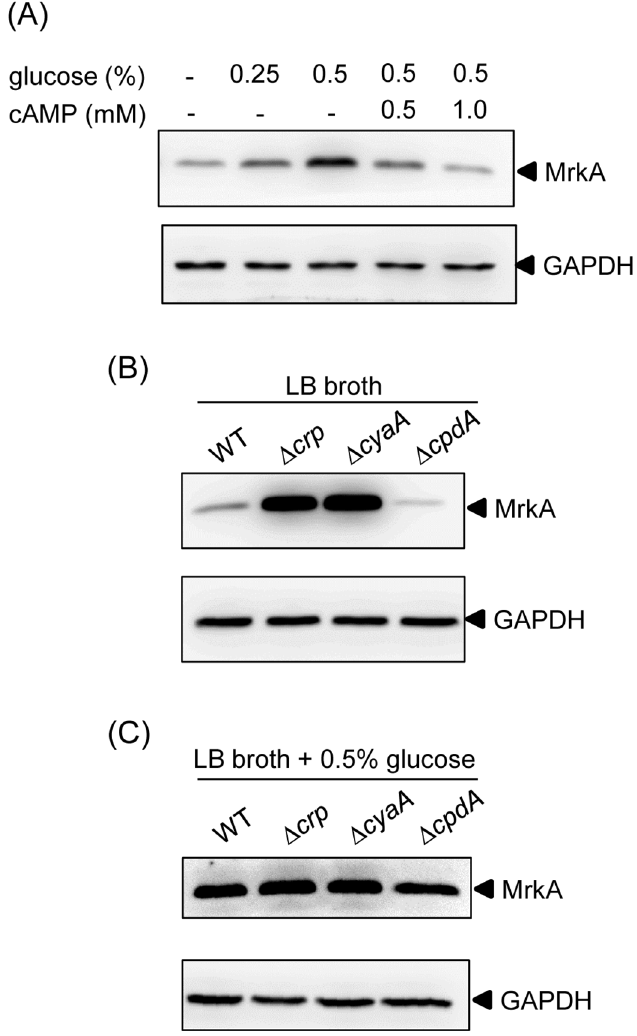
Fig 1. Glucose and cAMP affects the type 3 fimbriae expression of K . pneumoniae CG43S3. (A) K . pneumoniae CG43S3 was grown overnight at 37°C with agitation in LB broth supplemented with glucose and cAMP as indicated. K . pneumoniae CG43S3 WT, Δ crp , Δ cyaA , and Δ cpdA strains was grown overnight at 37°C with agitation in LB broth alone (B) or LB broth with 0.5% glucose (C) at 37°C with agitation to observe the type 3 fimbriae expression by Western blot analysis against MrkA (the upper panel) and GAPDH antiserum (the lower panel, for internal control). The MrkA and GAPDH proteins are indicated by an arrow,